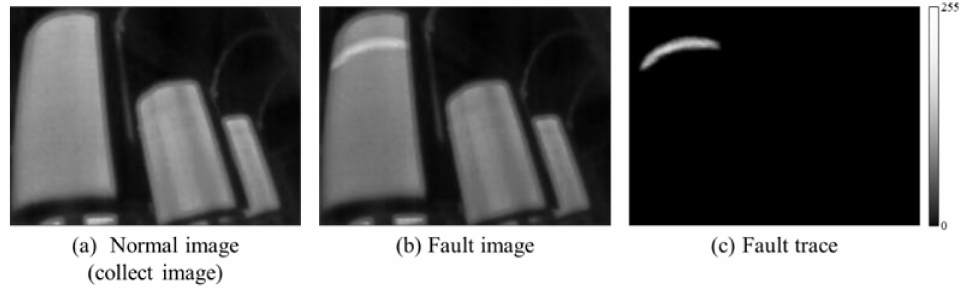
Figure 9. The fault trace making